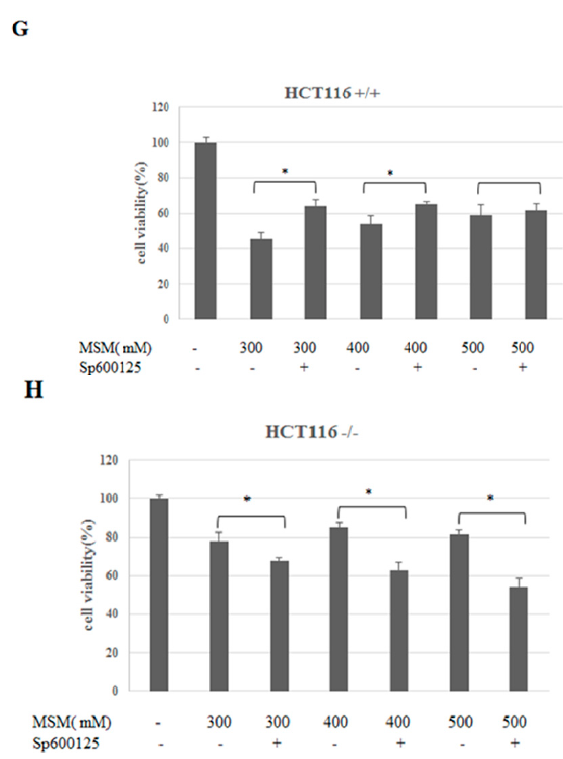
Figure 4. Effects of MSM on phosphorylated c-Jun N-terminal kinases (JNK) and unphosphorylated p38, p44/42, and JNK in HCT-116 p53 +/+ and p53 − / − colon cancers with or without MSM treatment. Cells were treated with MSM (100–800 mM) for 24 h and cell extracts were used for protein isolation and Western blotting for p38, p44/42, and JNK and p-JNK; β -actin was used as loading control. ( A ) Representative blot image showing the effect of MSM on unphosphorylated forms of p38 and p44/42 in HCT-116 p53 +/+ and p53 − / − colon cancer cells. No signal was detected for phosphorylated forms of p38 and p44/42 in HCT-116 p53 +/+ and p53 − / − colon cancer cells; ( B ) representative blot image showing the effect of MSM on unphosphorylated and phosphorylated forms of JNK. A very weak signal was detected for p-JNK in cells without MSM treatment. MSM treatment did not show any effect on unphosphorylated forms of p44/42, JNK, and p38 mitogen activated protein kinases (MAPKs) but HCT-116 p53 +/+ and p53 − / − colon cancer cells showed a